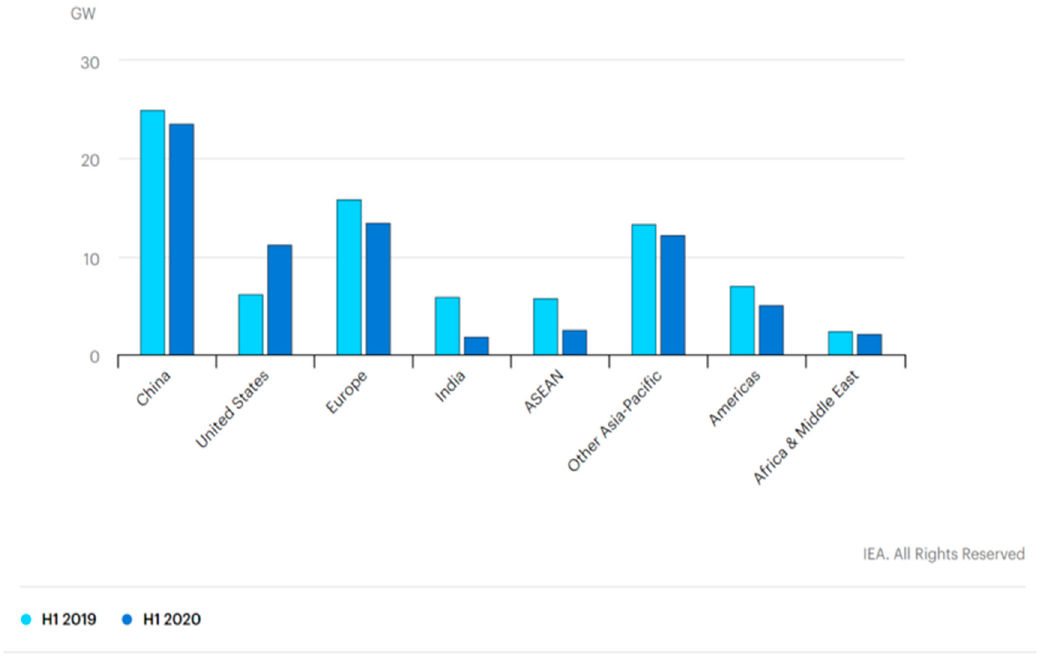
Figure 2. Energy capacity expansion by region during the lockdown of 2019–2020 [14].